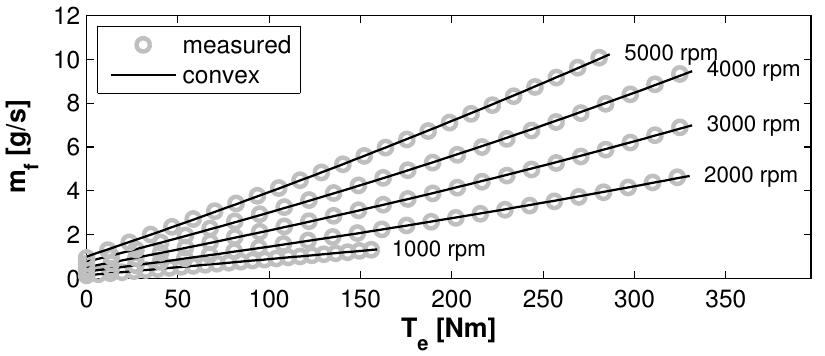
Figure 3. Fit of the convex engine